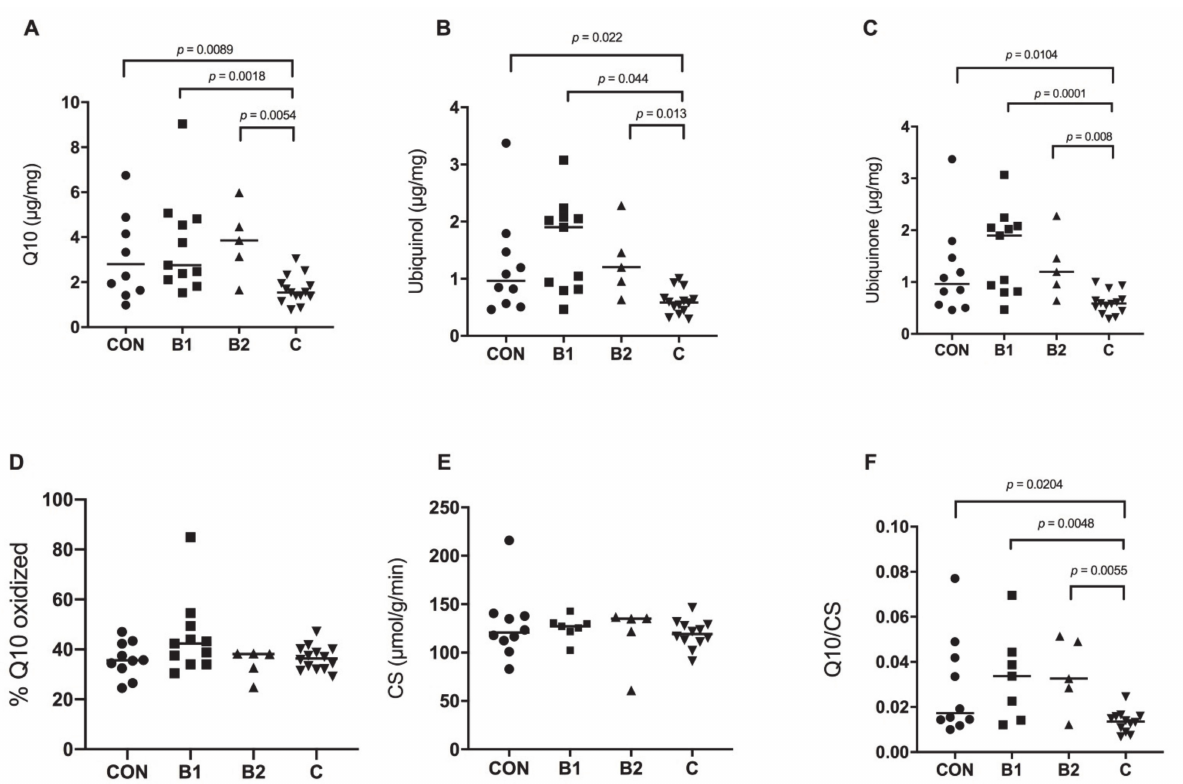
Figure 1. Myocardial concentrations of coenzyme Q10 and citrate synthase (CS) activity in control dogs with no evidence of heart disease (CON, n = 10), and in CKCS with MMVD in stage B1 ( n = 11), stage B2 ( n = 5) and stage C with CHF ( n = 14). Horizontal lines indicate median values. ( A ) Total myocardial Q10, ( B ) Ubiquinol, the reduced form of Q10, ( C ) Ubquinone, the oxidized form of Q10. ( D ) Oxidation ratio (% of total Q10 that is oxidized). ( E ) Citrate Synthase activity, ( F ) Ratio between Q10 and citrate synthase activity in the disease